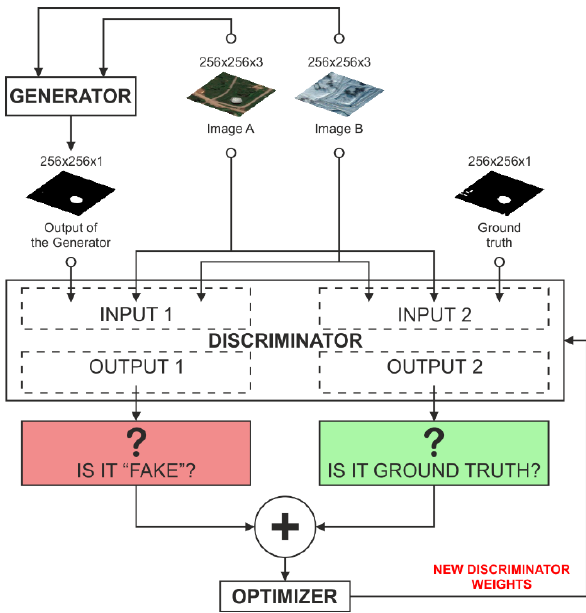
Figure 2. The training pipeline of the discriminator At the next training step, the generator parameters are updated using classification error using the discriminator output